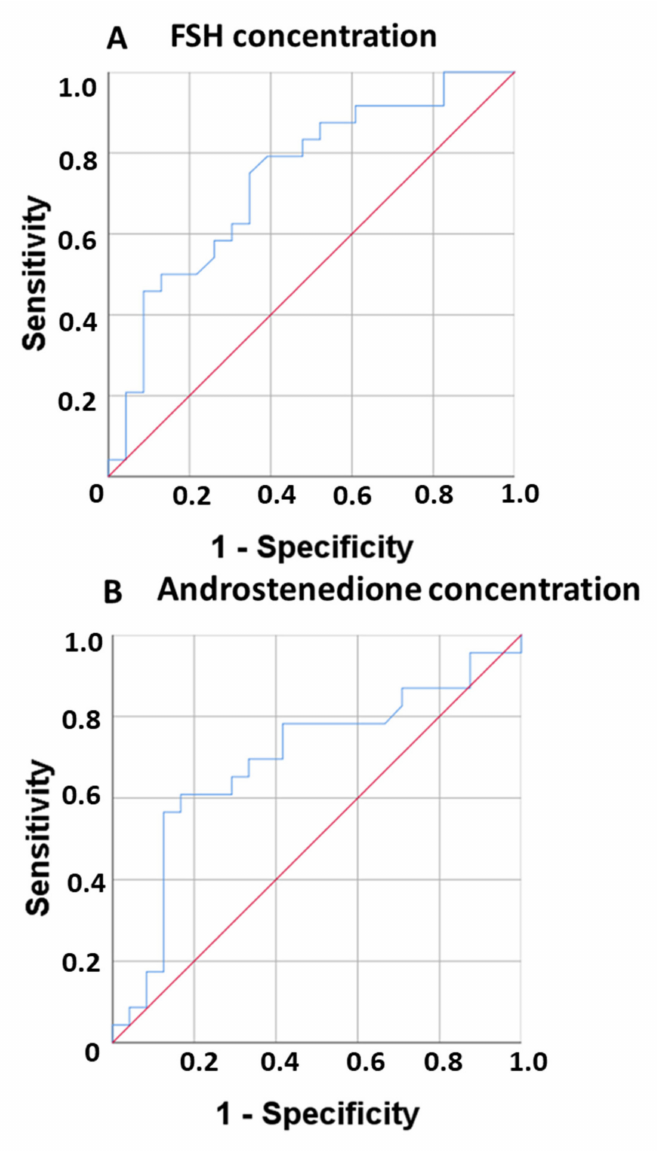
Figure 3. Receiver operating characteristic (ROC) curve for FSH ( A ) and androstenedione ( B ). The red line represent a hypothetical ROC curve of a perfect classifier. The blue curve represent the real ROC curve